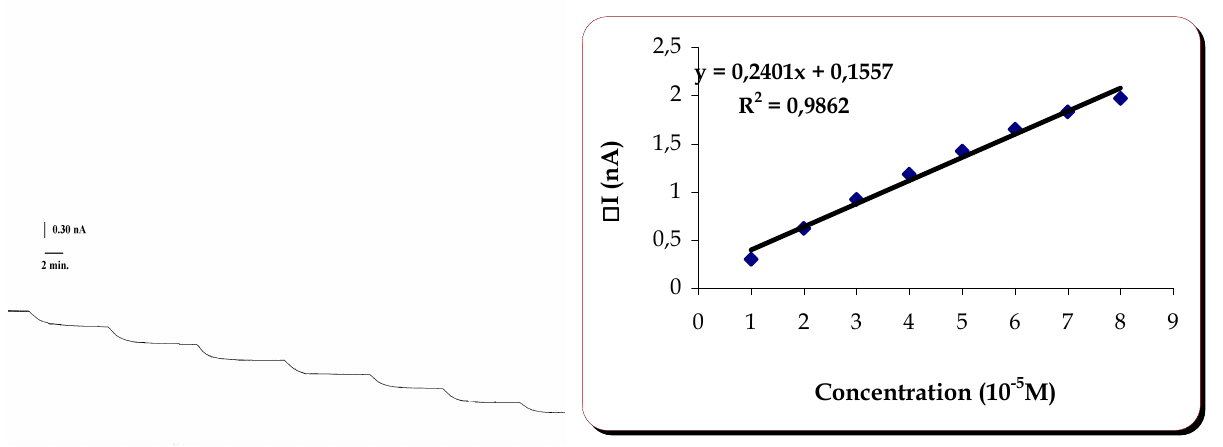
Figure 6. Linearity of response of the laccase containing biosensor to caffeic